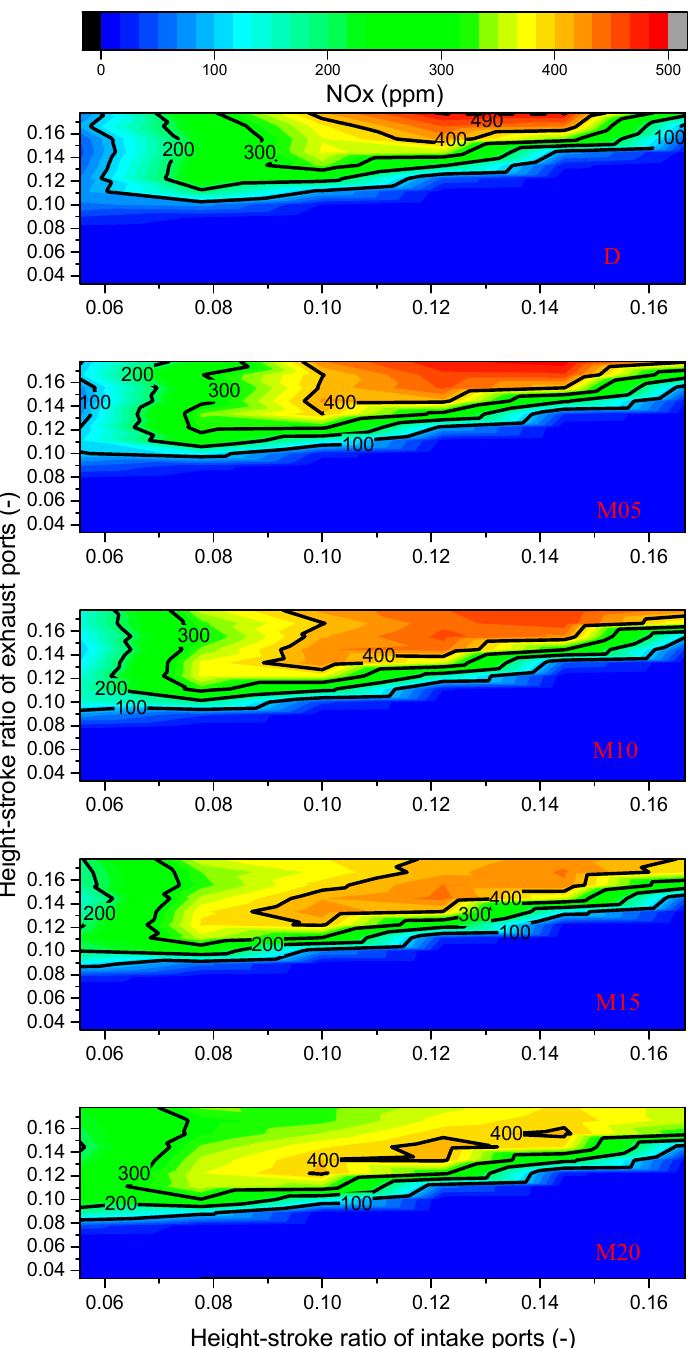
Figure 12. Indicated thermal efficiency under the interaction of the intake and exhaust ports. Figure 13 illustrates the NOx under the interaction of the intake and exhaust ports. When the HSR of the intake and exhaust ports are both large, NOx is the largest. With the methanol ratio increasing, the area with higher NOx reduces. The area with NOx greater than 490 ppm only appears in the condition of D. This means that the diesel mixed with methanol helps reduce NOx emissions. This is consistent with the results of Reference [20]. When the methanol ratio is below 10%, the area with NOx greater than 400 ppm gradually rises. After the methanol ratio exceeds 15%, the area with NOx greater than 400 ppm reduces significantly. That means the methanol ratio should be kept above 10% to reduce NOx emissions.